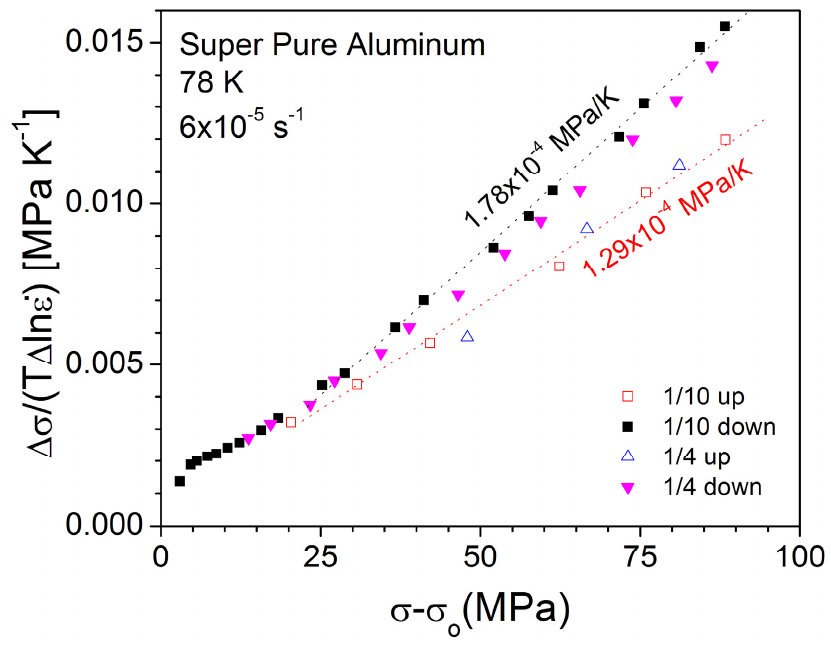
Figure 12. Haasen plot of 300 μ m grain-sized super pure Al tested at 78 K. The data points for the up- and down- rate changes are separated. The ¼ and 1/10 changes tend to diverge for the down- but not for the up-change, indicating that the composite locus encompass more than one weak species. For these reasons the analyses are based primarily on 1/10 rate change data. Although an ambiguity may result in the selection of the start point of S for locus, it was taken to be at the intersection of the S up with σ 0.2% . This procedure effectively subtracts the k/ ν SFT due to SFT found in the start material. If this locus now passes through the in- tersection point of S up and S down at σ 3 , it implies that other effects such as the contribution of attractive intersection is small. Graphically the intersection of S for with k/ ν up defines a horizontal line at (80 − Δσ ). Reforming S for = {k/ ν up − k/ ν yield }/(80 − 5 − Δσ ), Δσ was deter- mined. It follows then {k/ ν down − k/ ν up }/ Δσ = S debris . Furthermore, the fraction of flow stress due to the contribution of debris, f debris , was defined as { Δσ /( σ − σ 3 )} because the creation of debris begins at σ 3 . Note that a similar intersection of k/ ν up with σ 3 and S for gives rise to a small Δσ that is attributed to attractive intersection, but scrutiny of Figure 12 indicate it is less than 10% of that for repulsive one. The above construction is based on the principle that 1/ ν = 1/ ν for + 1/ ν debris that follows from the stress additivity assumption that τ = τ for + τ debris , and its differentiation results in the derived S down = (cid:2869) (cid:2904)(cid:2986)(cid:2922)(cid:2924)(cid:2980) (cid:2986)(cid:2922)(cid:2924)(cid:2963)(cid:4662) (cid:4698) (cid:2904) = (1-f debris ) (cid:2869) (cid:2904)(cid:2986)(cid:2922)(cid:2924)(cid:2980) (cid:3164)(cid:3173)(cid:3176) (cid:2986)(cid:2922)(cid:2924)(cid:2963)(cid:4662) (cid:4698) (cid:2904) + f debris (cid:2869) (cid:2904)(cid:2986)(cid:2922)(cid:2924)(cid:2980) (cid:3162)(cid:3163)(cid:3160)(cid:3176)(cid:3167)(cid:3177) (cid:2986)(cid:2922)(cid:2924)(cid:2963)(cid:4662) (cid:4698) (cid:2904) whereby f debris = ( τ debris / τ ) = Δσ /( σ − σ 3 ). Thus, if the difference in the derived S down to the experimental S down is small the contribution from attractive intersections is assessed to be small. Thus, the agreement of derived and experimental values is taken to indicate that the deduced analyses is reli- able. Note that conversion of Haasen plot to shear stress to determine S is not necessary since both axes are proportional to the Taylor factor M using ( σ − σ 0 ) = M τ .